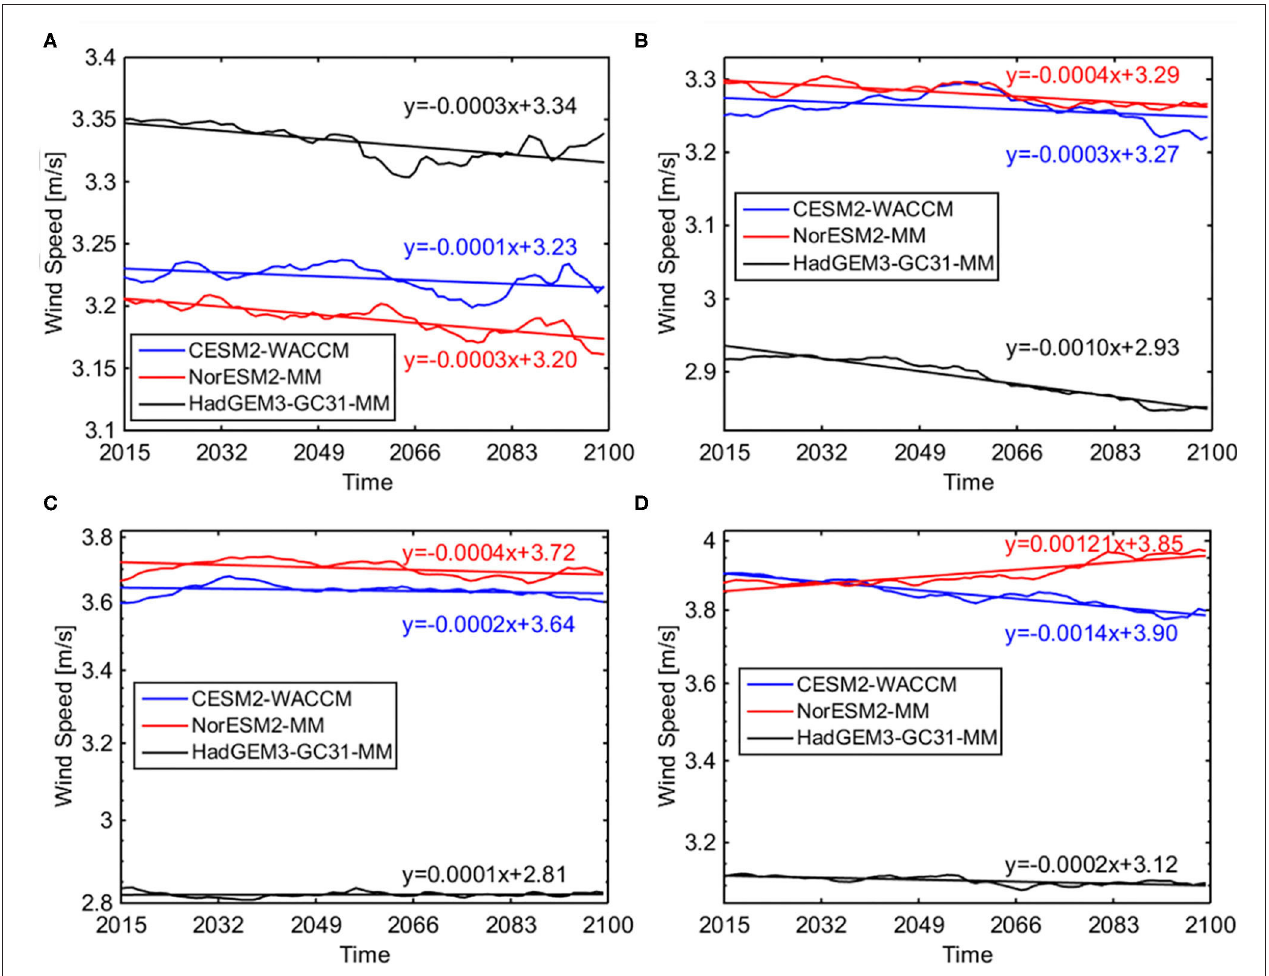
FIGURE 7 | The wind speed of ssp585 simulation in the four specific regions from CESM2-WACCM, NorESM2-MM, and HadGEM3-GC31-MM. (A–D) Region I, region II, region III, and region IV, respectively.